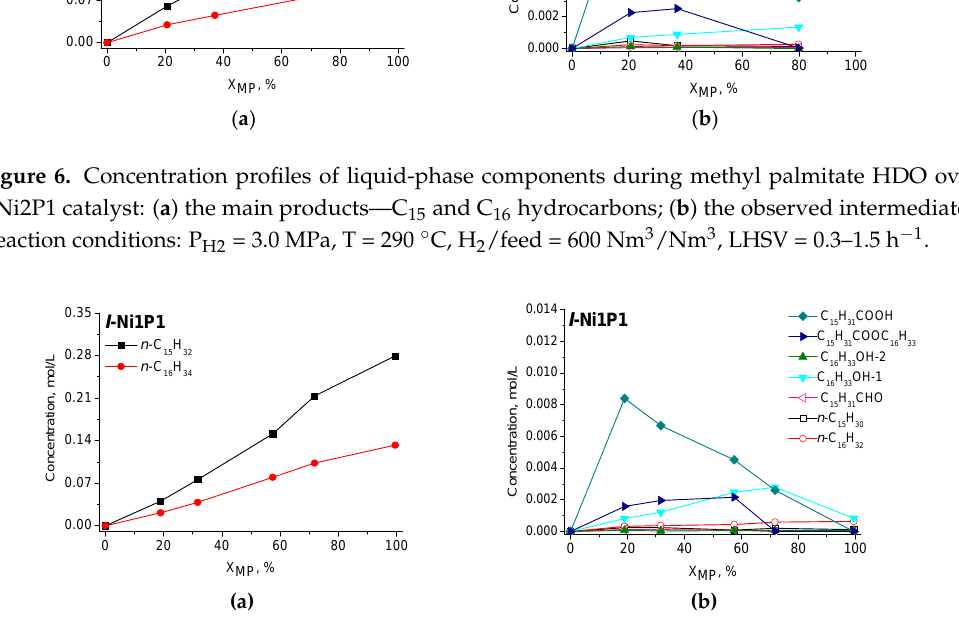
( b ) Figure 8. Concentration profiles of the liquid ‐ phase components during methyl palmitate HDO over l ‐ Ni1P2 catalyst: ( a ) the main products—C 15 and C 16 hydrocarbons; ( b ) the observed intermediates. Reaction conditions: P H2 = 3.0 MPa, T = 290 °C, H 2 /feed = 600 Nm 3 /Nm 3 , LHSV = 0.3–6.4 h − 1 . 0